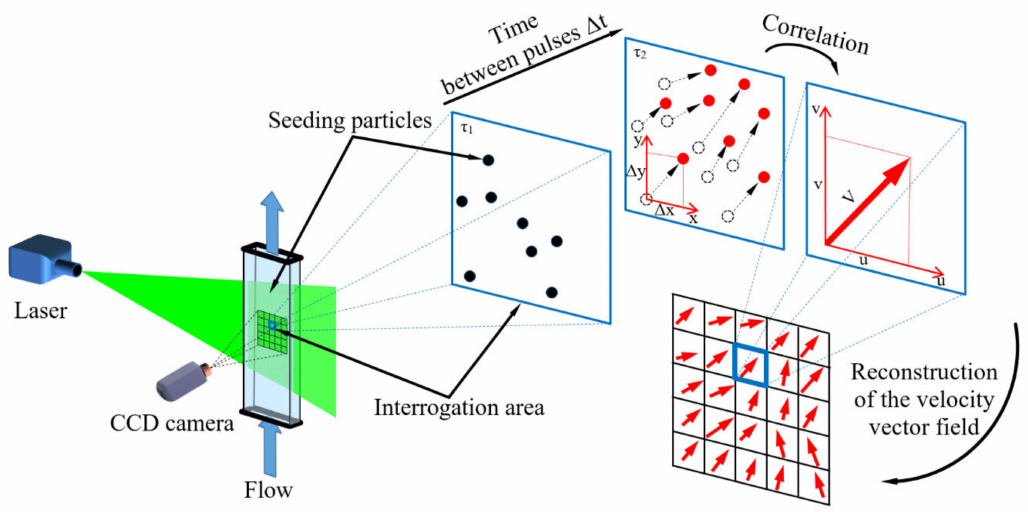
Figure 2. Idea of measurements applying the particle image velocimetry (PIV)